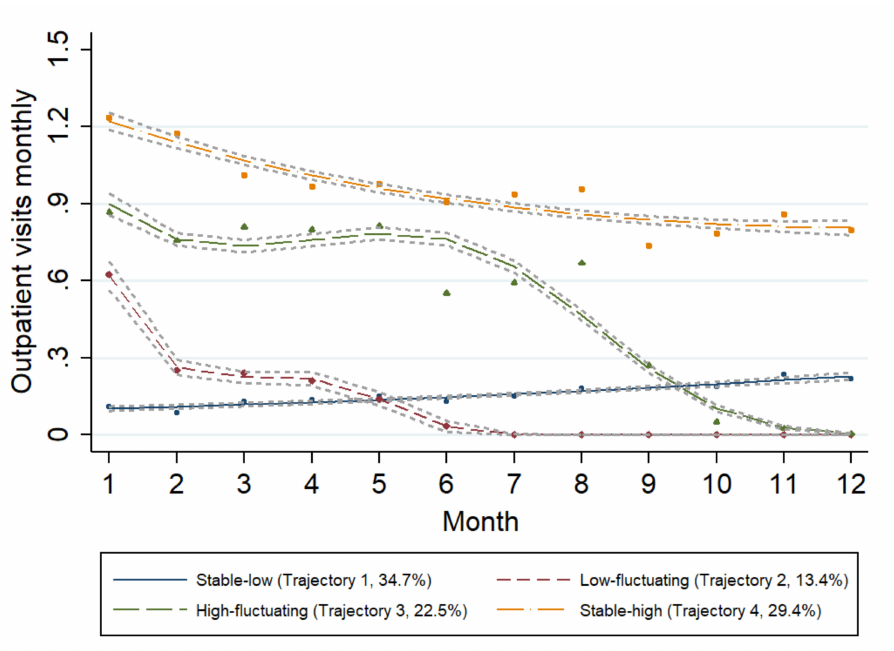
Figure 1. Trajectories of outpatient service utilisation over time ( n =